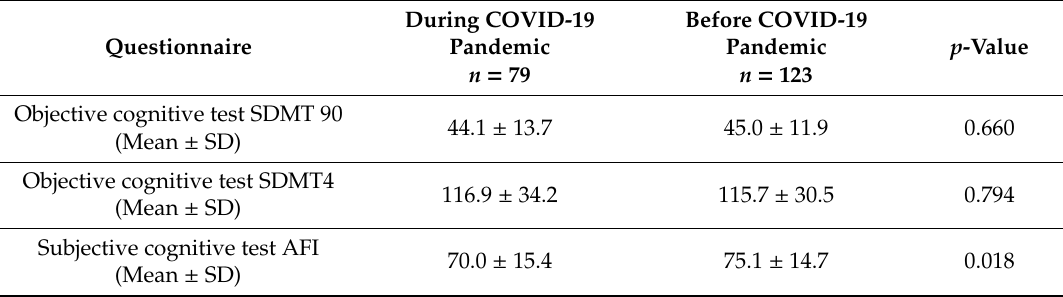
Table 3. Objective and subjective cognitive tests results of women delivering during and before the COVID-19